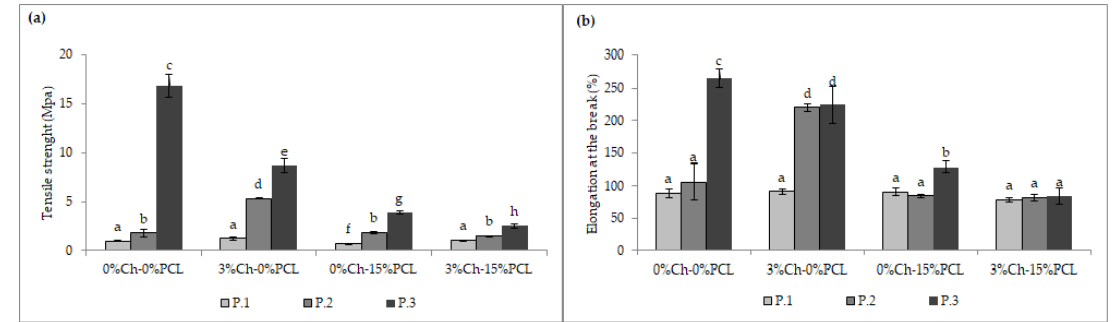
Figure 1. Mechanical properties of the synthesized PUs. ( a ) Maximum stress of PUs; ( b ) Percent elongation of PUs. The data are expressed as the mean ± SD (n = 3). Bars with different letters (a–h) indicate significant differences ( p < 0.05) between the polyols.